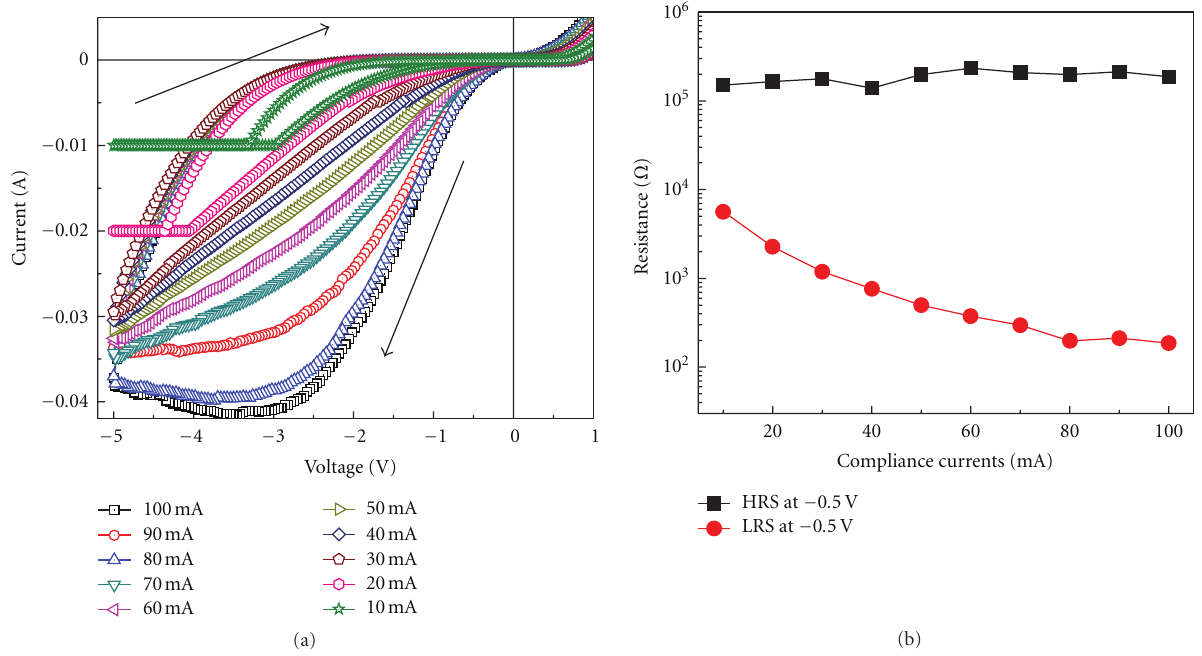
Figure 4: (a) RS characteristics for various compliance currents. (b) The compliance currents dependence of R HRS and R LRS .